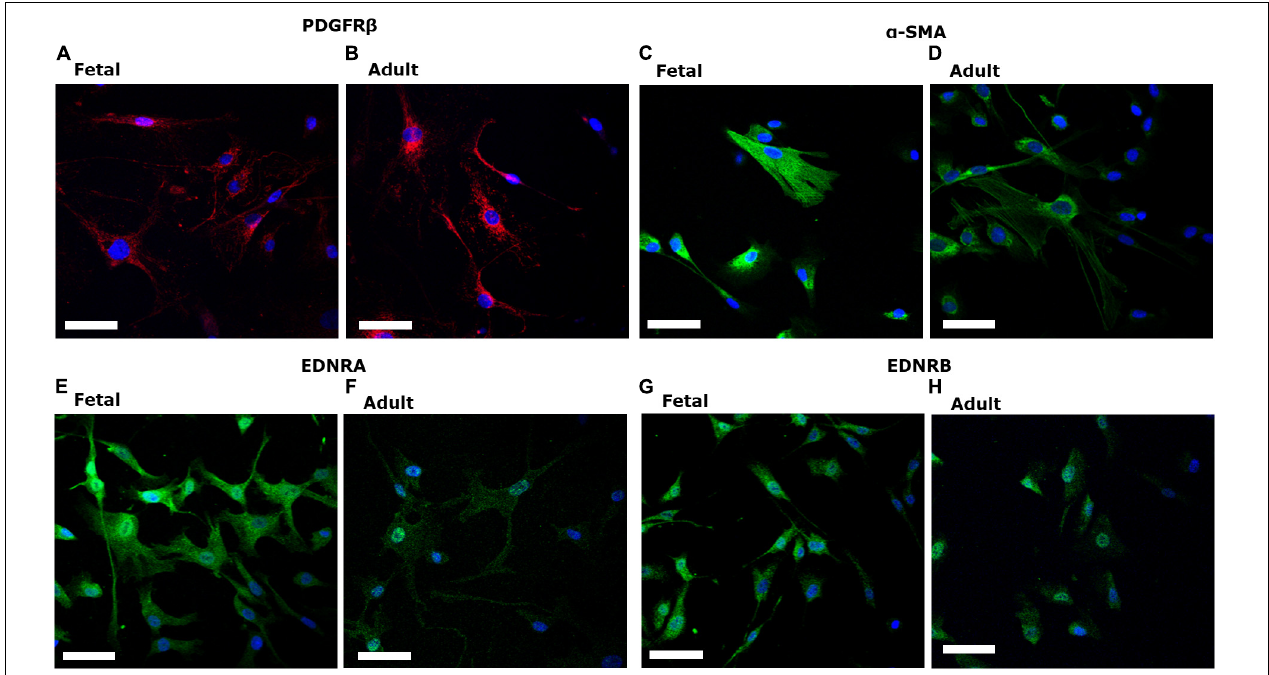
FIGURE 1 | Fetal human brain-derived vascular pericytes (fHBVP) and adult human brain-derived vascular pericytes (aHBVP), expressed PDGFR β (A,B) , α -SMA (C,D) and both endothelin-1 type A (EDNRA) (E,F) and type B (EDNRB) receptors (G,H) . All counterstained with a nuclear marker (DAPI – blue). Magnification 40 × . Scale bar represents 50 µ